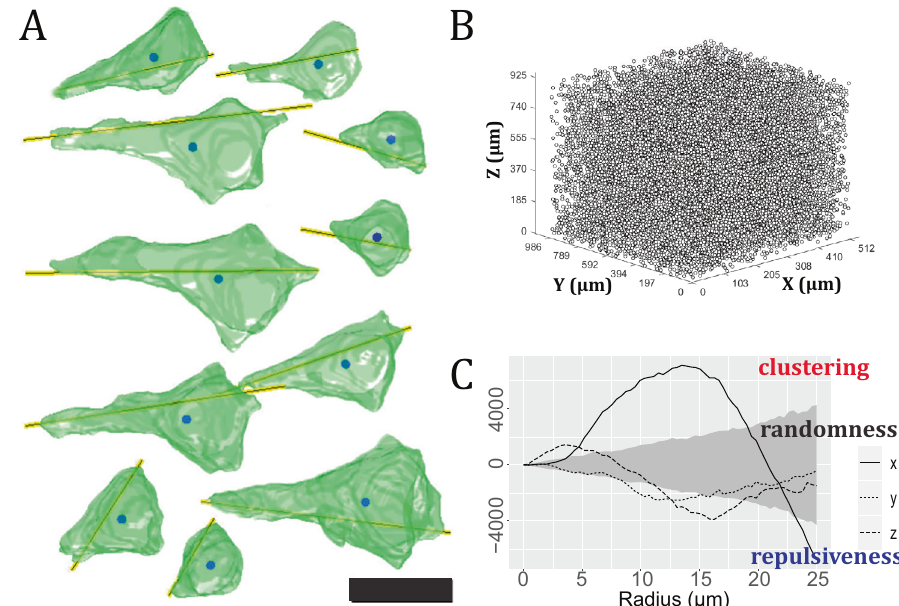
Fig. 2 Quantitative measurements of 3D-reconstruction. A Pyramidal cell reconstruction in 3D, with yellow lines denoting orientation and solid circles denotes the centroid of pyramidal cells. Scale bar = 20 µm. B Point pattern consisting of centroids of pyramidal cells in layer III of BA46 acquired from a biopsy. C The results of a spatial point pattern analysis of pyramidal cell centroids using the cylindrical K -function. The empirical cylindrical K -function in the directions of the three axes is shown as three curves: x -axis (solid line), y -axis (dotted line), or z -axis (dashed line). The observed point pattern is completely random only if the curves fall within the envelope (gray area). When a curve falls above the envelope, it indicates evidence of clustering; when a curve falls below the envelope, it indicates evidence of repulsiveness. If the curve in one direction is particularly high, it indicates cylinder-shaped clusters in this